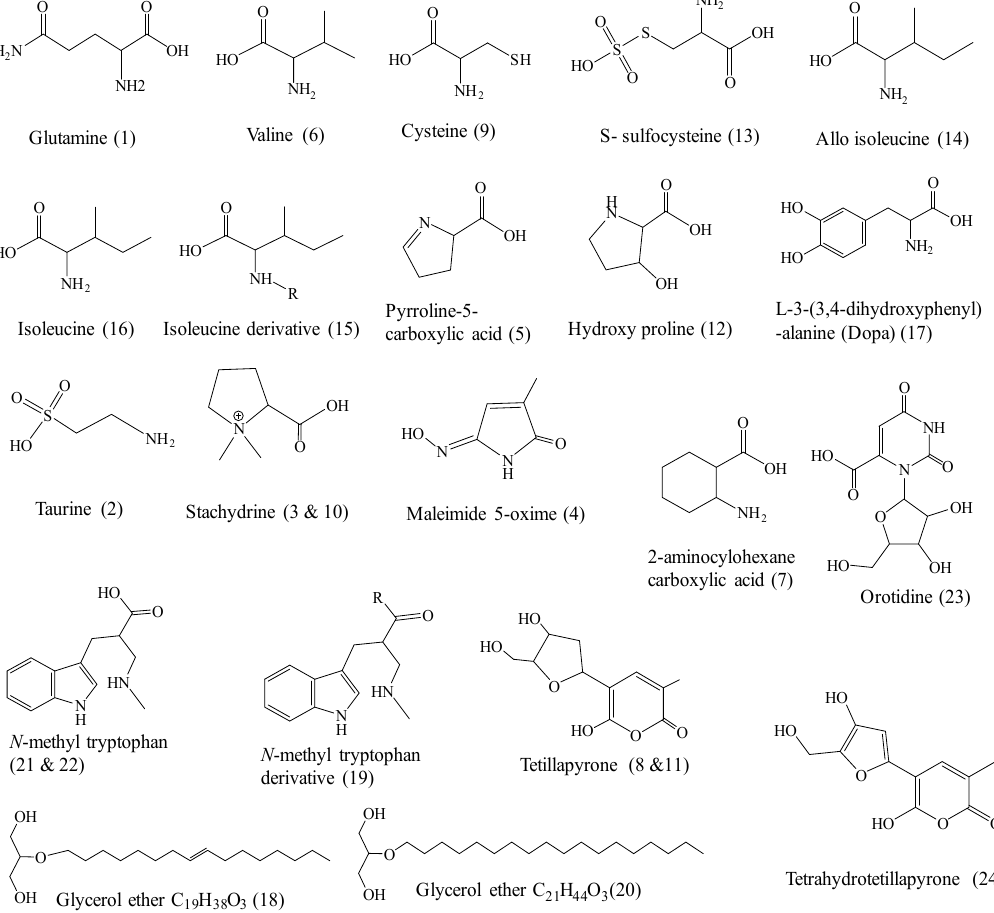
Figure 8. Chemical structures of the tentatively identified compounds from ethyl acetate fraction of Cliona sp.